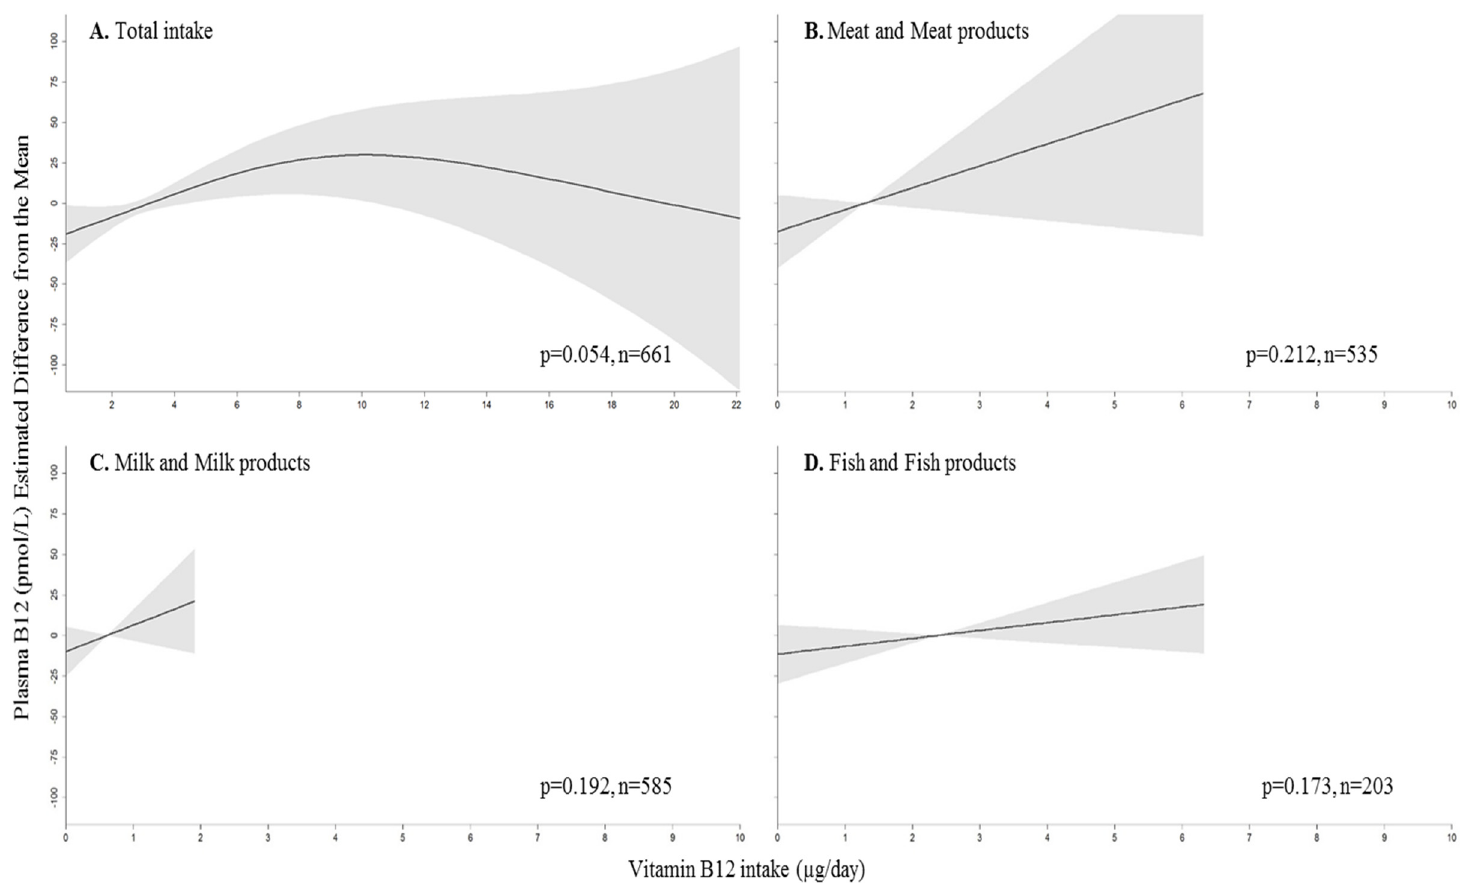
Figure 2. Estimated difference from the mean (and 95% CI) of plasma B12 concentrations according to vitamin B12 intake from A. all dietary sources, B. from meat and meat products, C. from milk and milk products and D. from fish and fish products. Generalized additive model (gam) adjusted for sex, energy intake, FUT2 genotype, H 2 antagonists, proton pump inhibitors or biguanides use, vitamin B12 supplement use and vitamin B12 intakes from the other two food sources. The lowest and highest 2.5th percentiles of vitamin B12 intakes and plasma vitamin B12 concentrations are not included except for meat and meat products where the highest 5th percentile was excluded. p values are from the corresponding gam model.